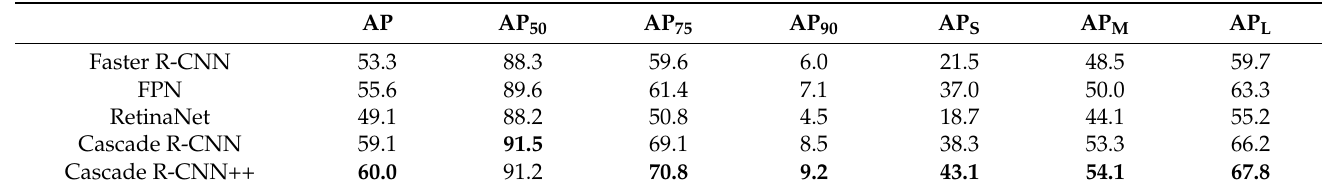
Table 5. Comparison with popular baseline detectors on NWPU VHR-10 dataset, all with Resnet-50 backbone.